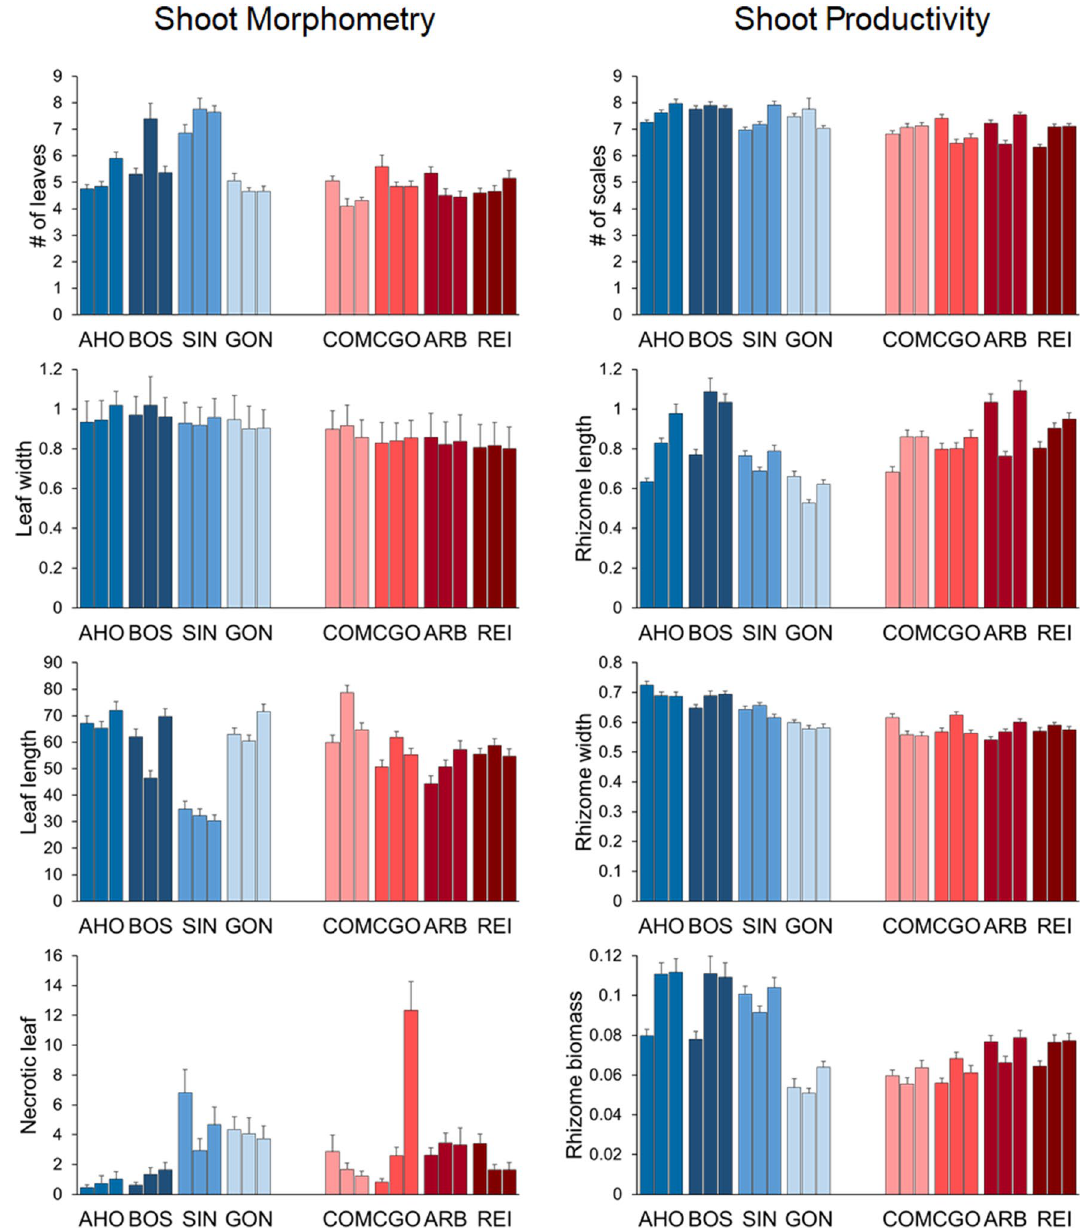
Figure 2. Posidonia oceanica. Mean (+ SE) morphometry (left) and productivity (right) variables. Morphometry: # of leaves/shoot, leaf width (cm), length (cm), and necrotic leaf portion (%). Productivity: #